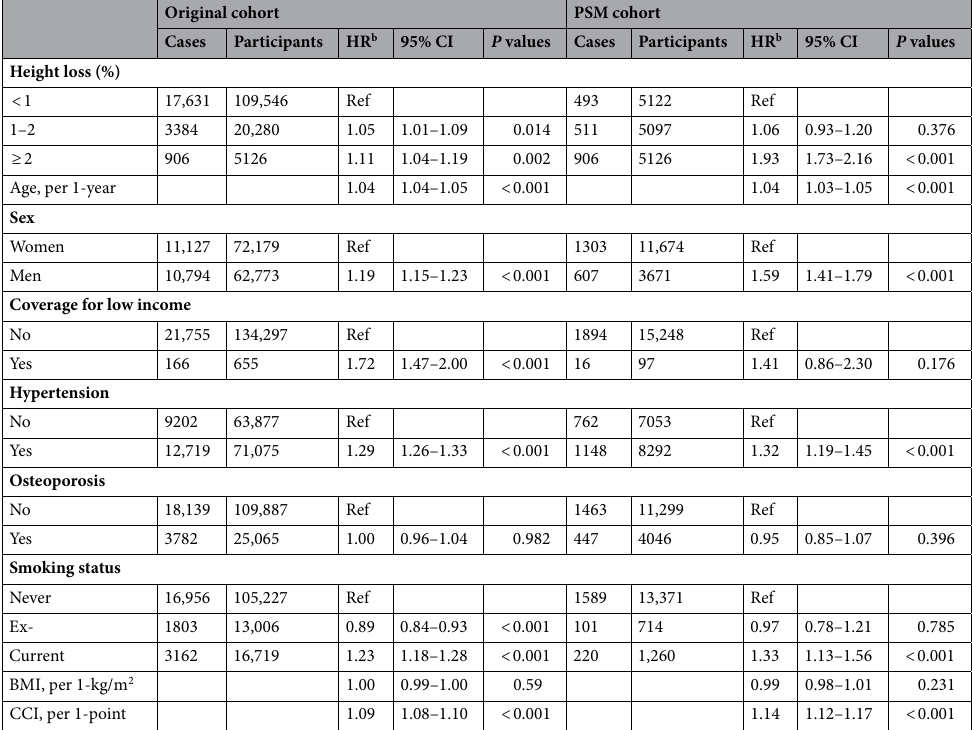
Table 2. Factors associated with incidence of cardiovascular diseases a , including the degree of height loss. BMI model.